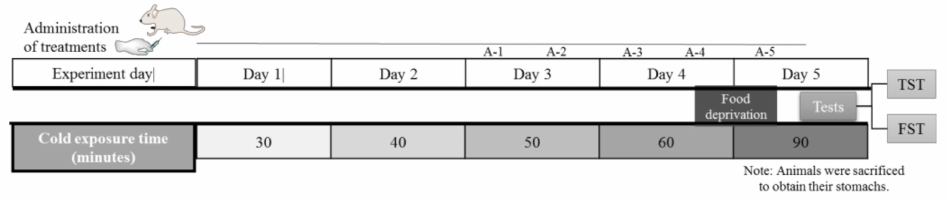
Figure 7. Chronology of the experimental design is modified from the sub-chronic stress model used in biological tests: Cold restraint stress (CRS), tail suspension test (TST) and forced swimming test